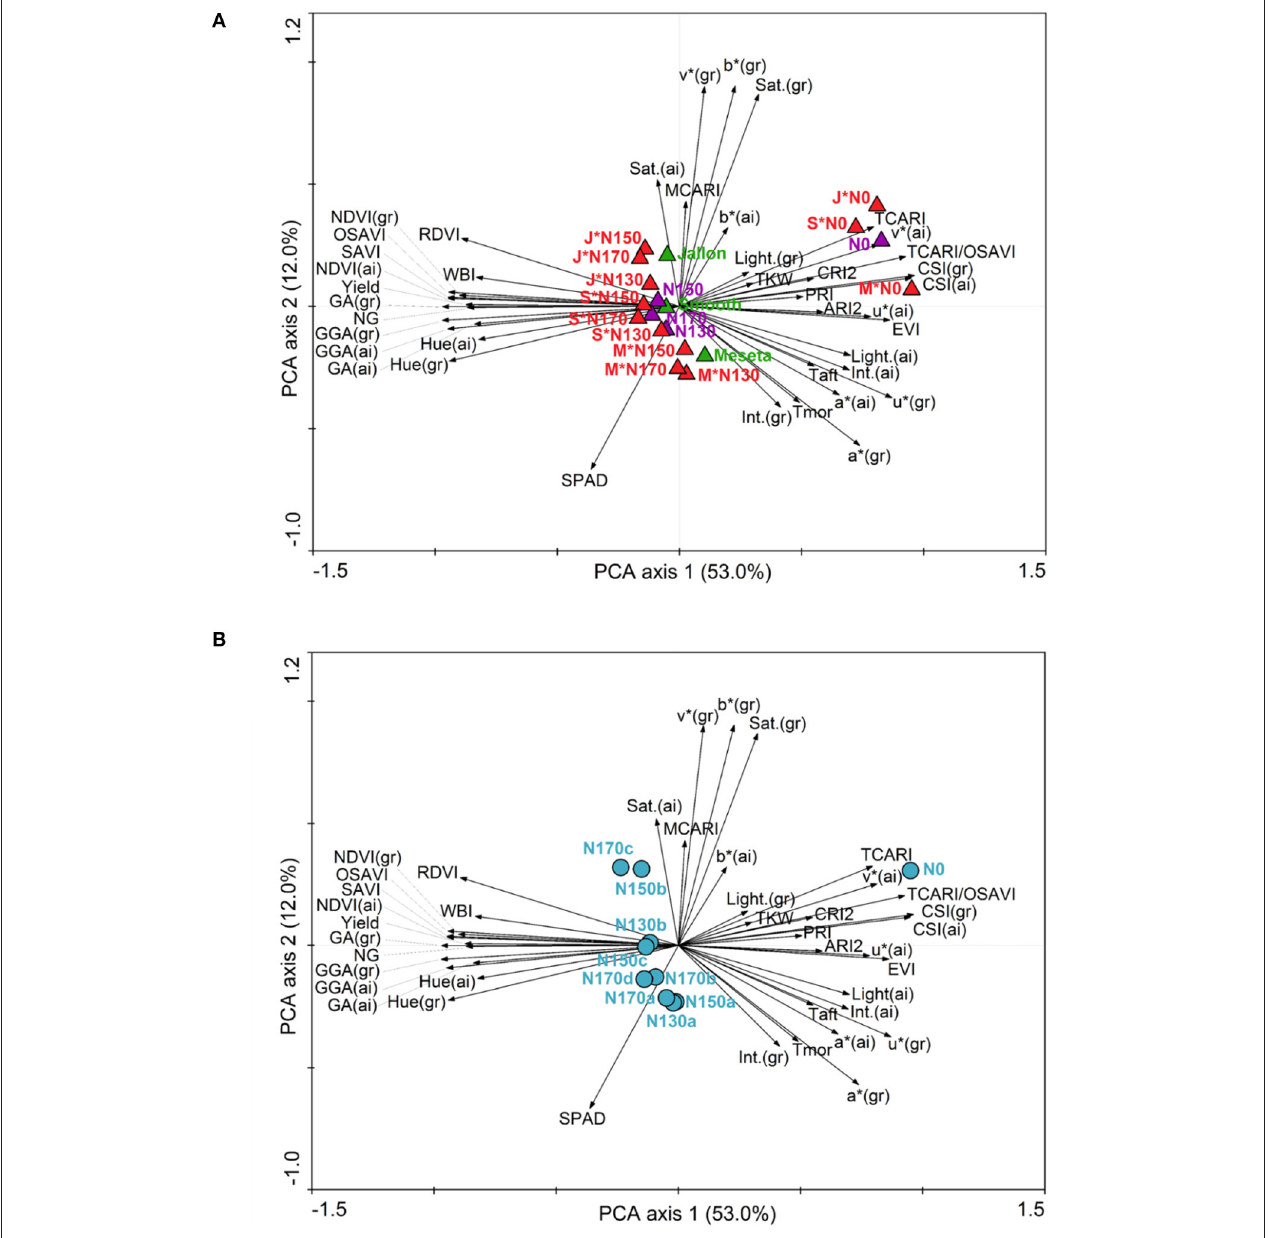
FIGURE 2 | Principal component analysis (PCA) of agronomical and physiological traits in three barley genotypes at different N levels. Arrows represent the variables and triangles the different genotypes (green), N levels (purple) and their interaction (red) in (A) , and circles the different N levels and application dates in (B) according to Table 1 . M, Meseta; J, Jallon; S,